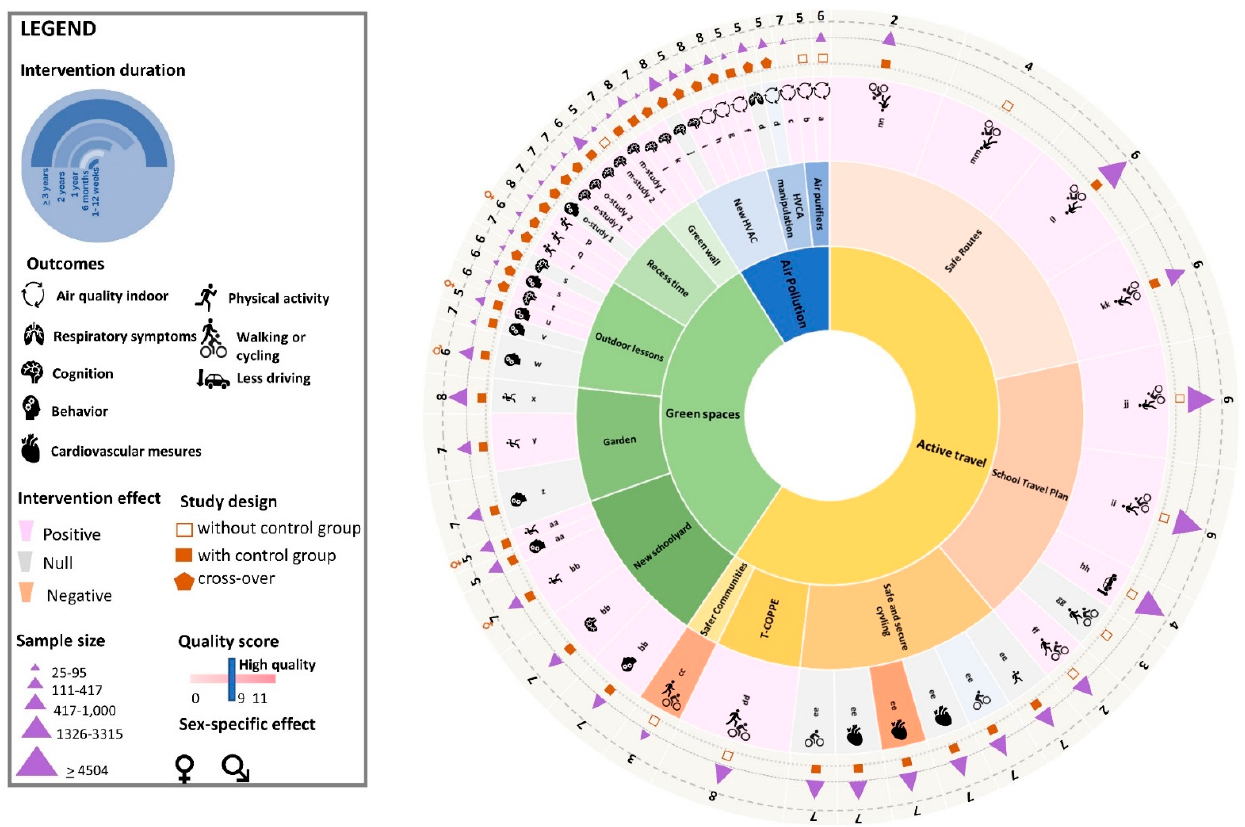
Figure 3. Impact of interventions per exposure target. Each slice represents an outcome. One study can have more than one eligible outcome. For more details on each intervention study see Supplementary Material S2. a = [41] effect dependent on the school location (level of nearby traffic) and year of construction (> or <15 years); b = [42] 2 school gyms from primary schools; c = [43] effect only for within late-start schools (9 AM) located near major roads; d = [44]; f = [46]; g = [47]; h = [48] not for outdoor generated pollutants (NO 2 and PM 2.5 ; i = [45]; j = [49]total number of errors in attention test increased significantly in worse condition; k = [50] significant results only when motivated students were kept, less eye pain in the recirculation condition; l = [66] only for selective attention not for processing speed; m-study 1 = [67] selective attention and working memory tests; m-study 2 = [67] only working memory tests; n = [60]; o-study 1 = [61]; o-study 2 = [61]; p = [62] playground